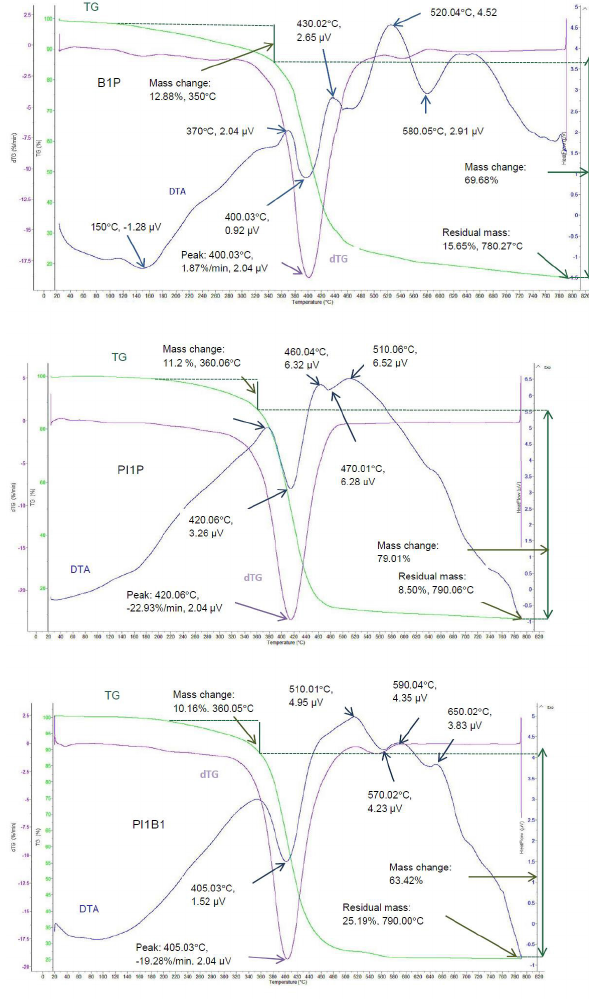
Figure 5: TG, DTG, and DTA curves of polyester composite